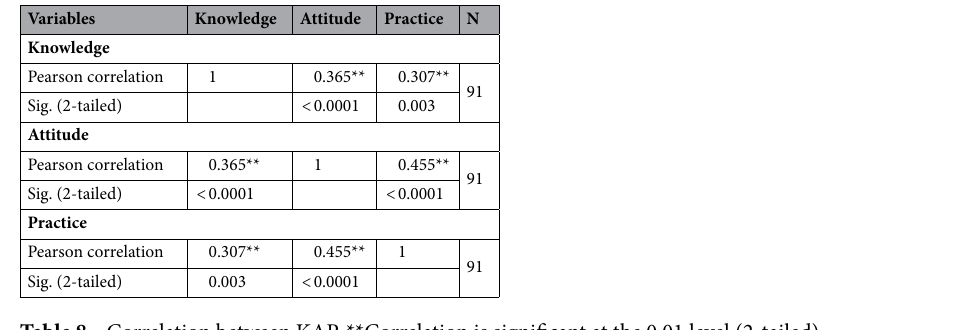
Table 8. Correlation between KAP. **Correlation is significant at the 0.01 level (2-tailed).